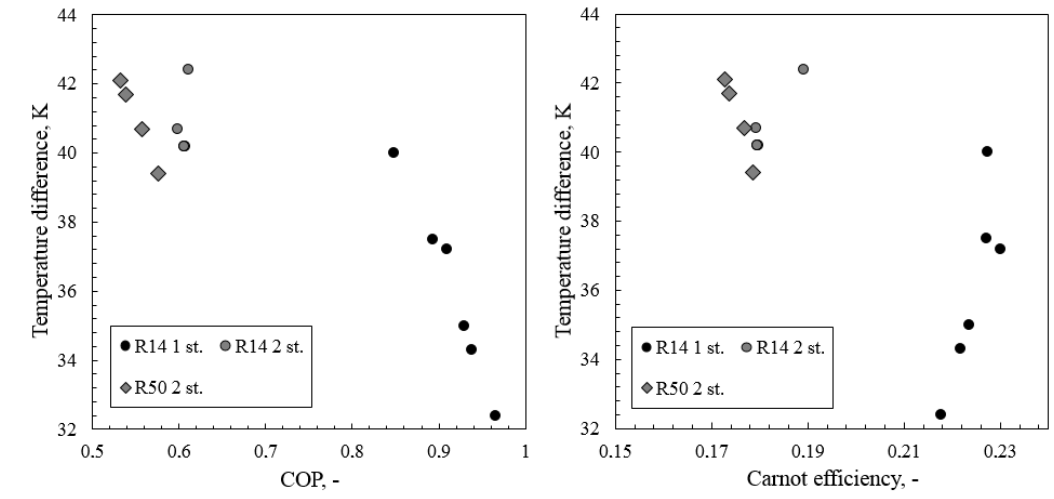
Figure 13. The performance of third-stage